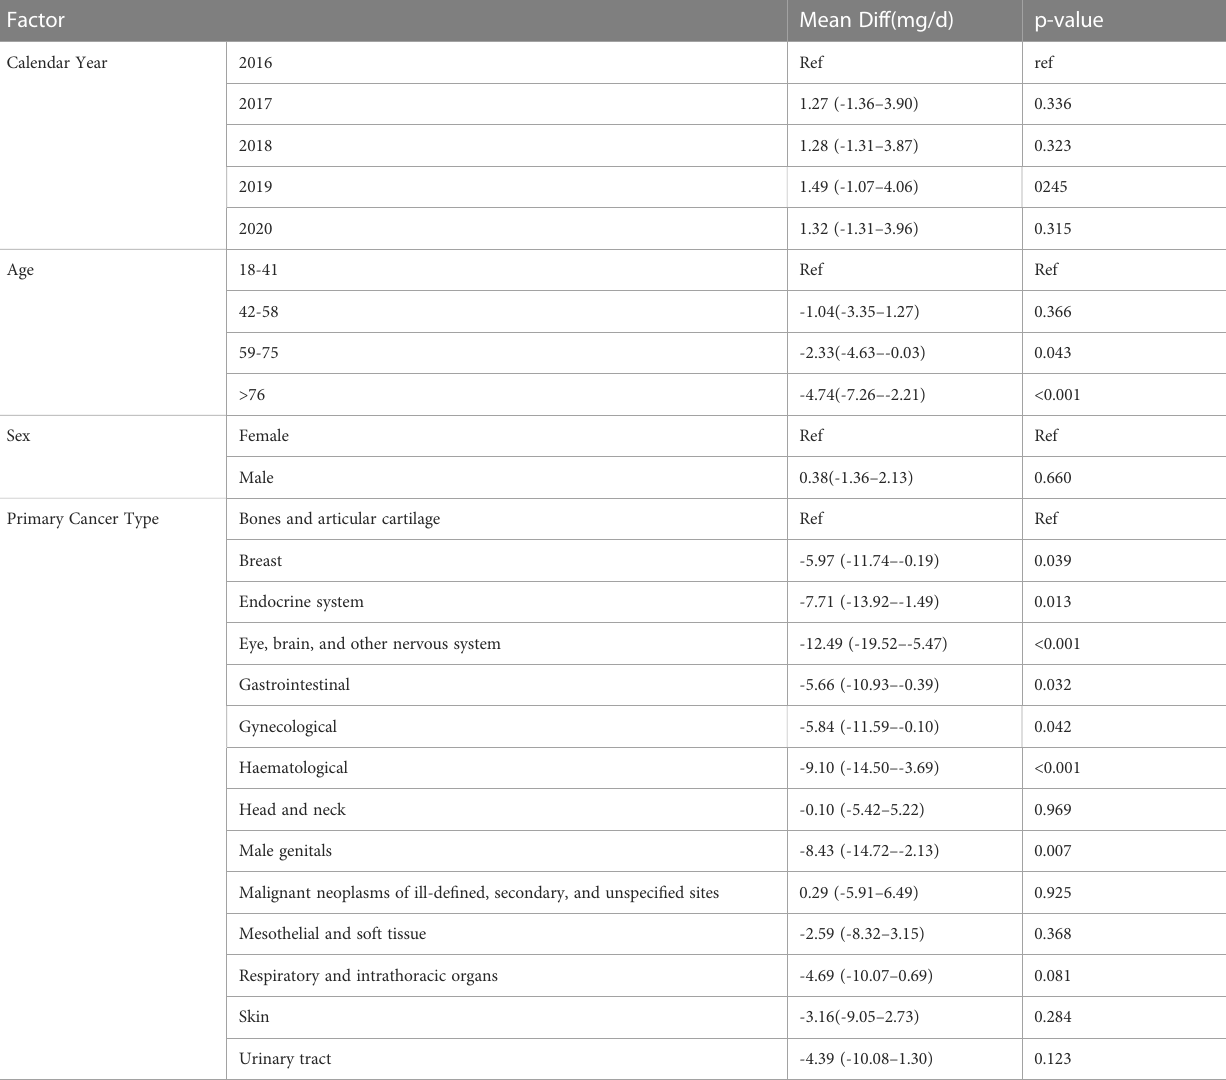
TABLE 3 Adjusted* morphine equivalent daily dose (MEDD) by age, sex, cancer type and calendar year from a generalized additive model (GAM).